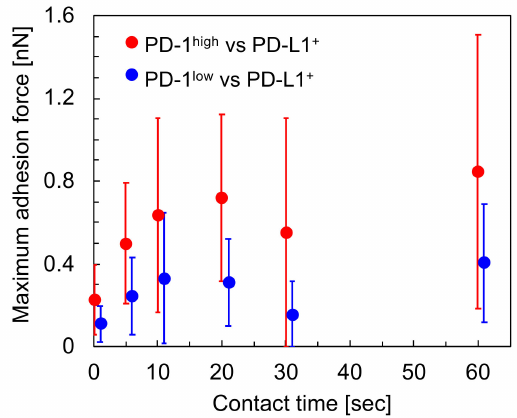
Figure 4. Relationship between maximum adhesion forces and contact time between PD-L1 + cancer cells and either PD-1 high (red) or PD-1 low (blue) T cells. Data points were a few shifted to left and right for visualization. p < 0.01 for all contact